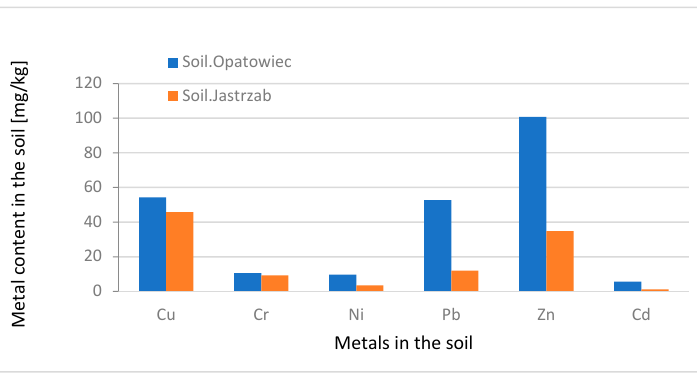
Figure 2. Total metal content in the soil from Opatowiec and Jastrzab (mg/kg d.m.).